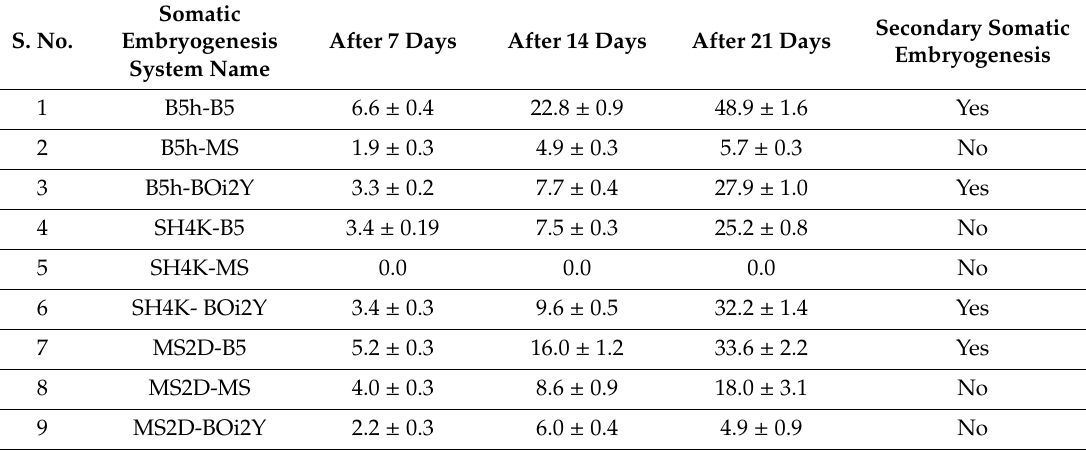
Figure 5. Secondary somatic embryogenesis. ( A ) Early secondary somatic embryogenesis where dense culture of mature somatic embryos giving rise to new globular embryos from the surface of primary embryos in B5h-B5 system. ( B and C ) Late secondary somatic embryogenesis where cotyledonary and torpedo staged secondary somatic embryos arising from the primary somatic embryos can be seen in the SH4K-BOi2Y system. All images were at 8× magnification.